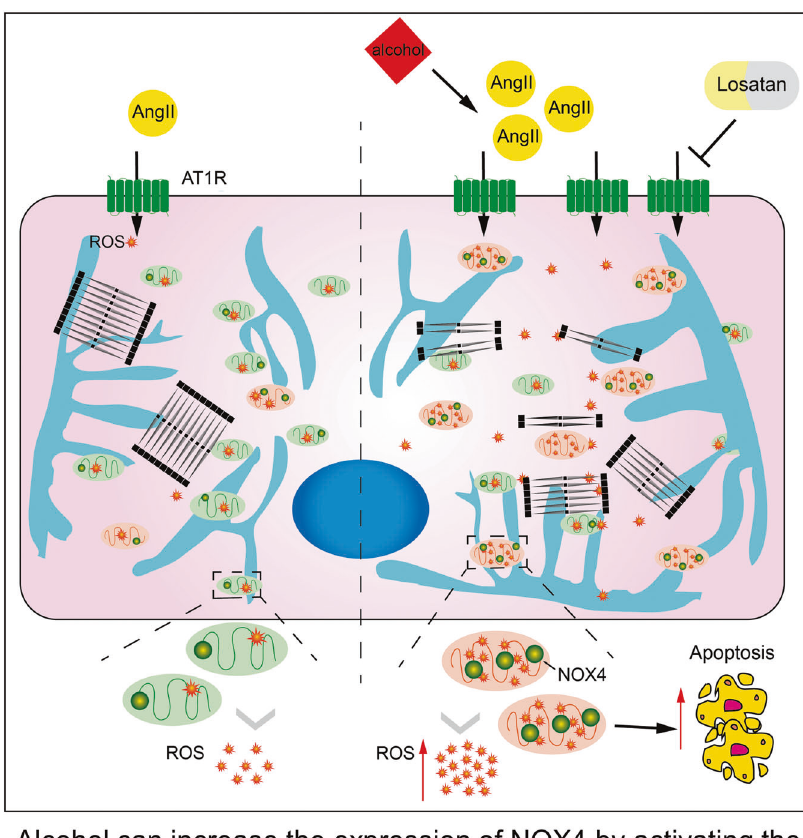
Fig. 6 Schematic illustration of alcohol-induced cardiomyocyte damage in hiPSC-CMs. Alcohol can increase the expression of NOX4 by activating the AngII – AT1R signaling pathway, increasing the production of ROS, and causing cardiomyocyte